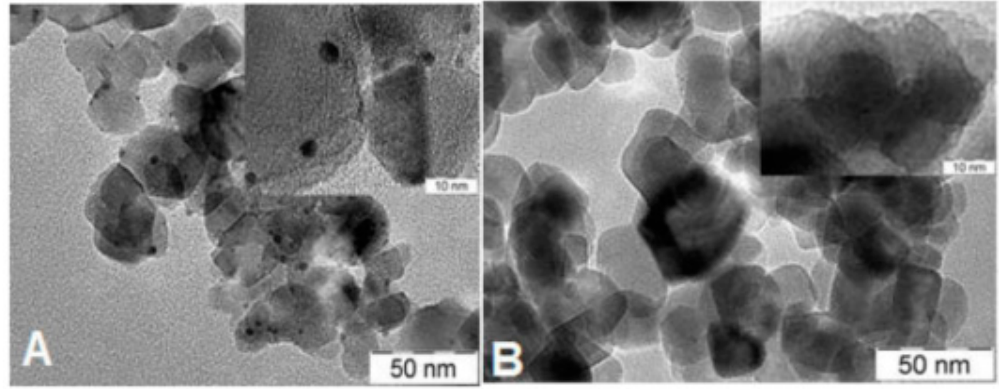
Figure 6. TEM images of P25-based Pt-PtO x /TiO 2 samples. ( A ) P25PtH 2 red; ( B ) P25PtCalc.